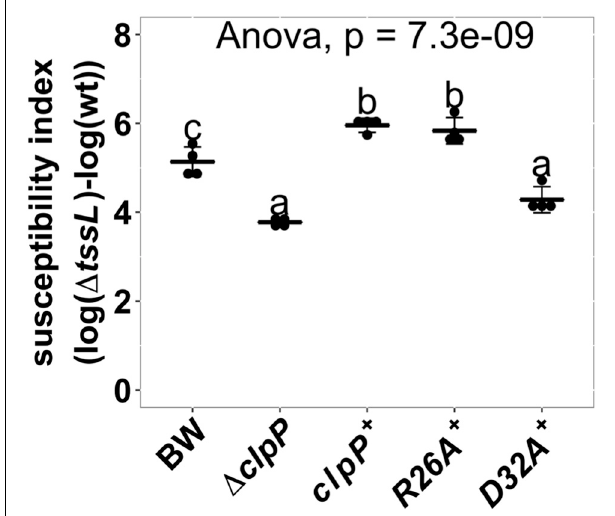
FIGURE 7 | Effects of ClpP variants impaired with ClpA-binding ability in enhancing Agrobacterium tumefaciens type VI secretion system (T6SS) antibacterial activity. Interbacterial competition assay between A. tumefaciens and Escherichia coli wild type, (cid:49) clpP , and (cid:49) clpP complement strains expressing wild-type ClpP ( clpP + ), ClpAP complex formation mutants ClpP R26A (R26A + ), and ClpP D32A (D32A + ). The ClpAP complex forming ability is half than that of wild-type ClpP in ClpP R26A and is completely lost in ClpP D32A (Bewley et al., 2006). The T6SS killing data are mean ± SD of four biological replicates from two independent experiments. Statistical analysis involved single-factor analysis of variance (ANOVA) and Tukey honestly significant difference (HSD) with P < 0.05 for statistical significance. Two groups with significant differences are indicated with different letters (a and